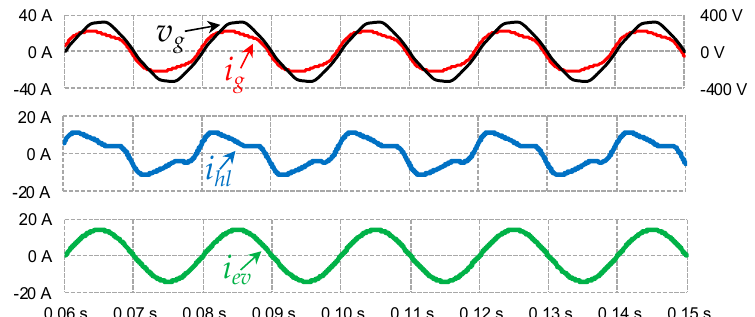
Figure 5. Principle of operation representative of the G2V mode.